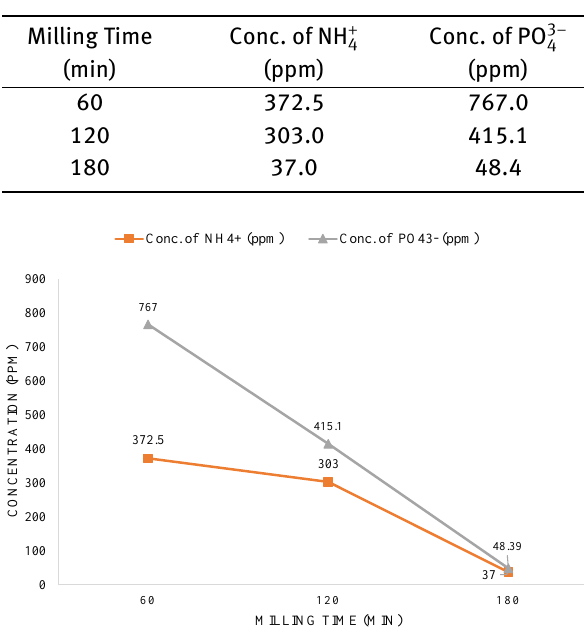
Figure 6. Nutrients release profile of Kaolin–(NH 4 ) 2 HPO 4 milled at 700 rpm at varying Figure 6: Nutrients release profile of kaolin–(NH 4 ) 2 HPO 4 milled milling time and disseminated in distilled water for 24h.